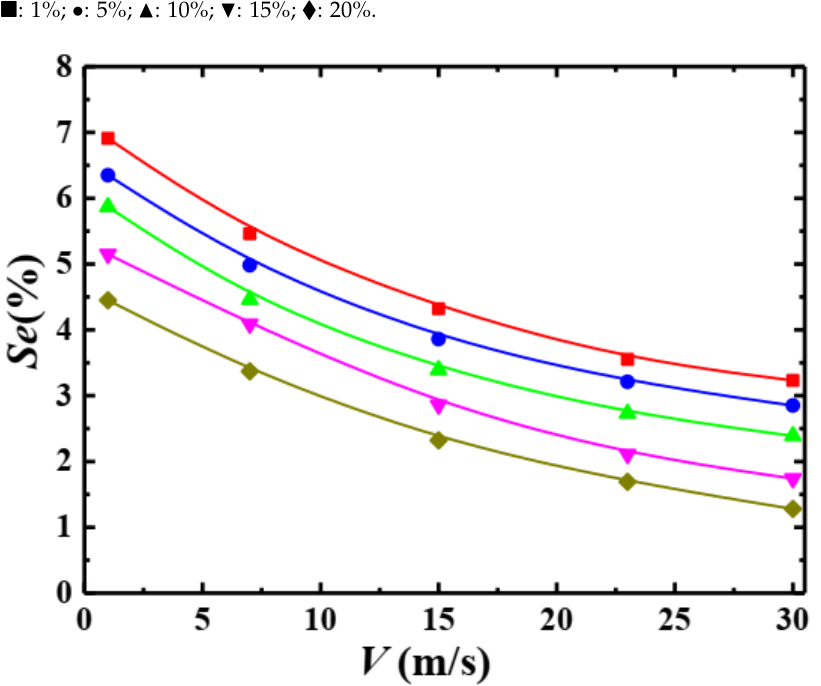
Figure 8. Relationship between Se and V for different particle mass flow ( d p = 100 µ m, α s =